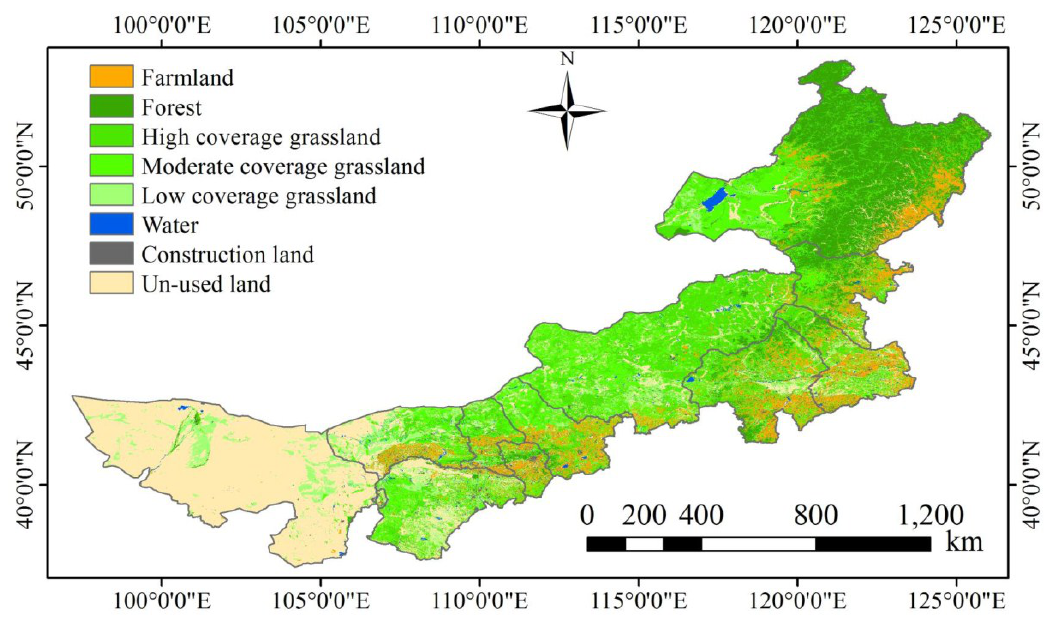
Figure 5. Land use in Inner Mongolian Plateau.